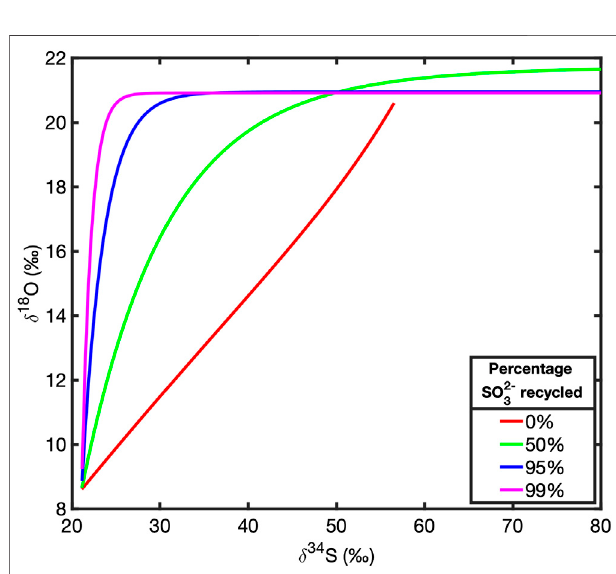
FIGURE 2 | Steady state plots of δ 34 S against δ 18 O in extracellular sulfate for various percentages of sul fi te